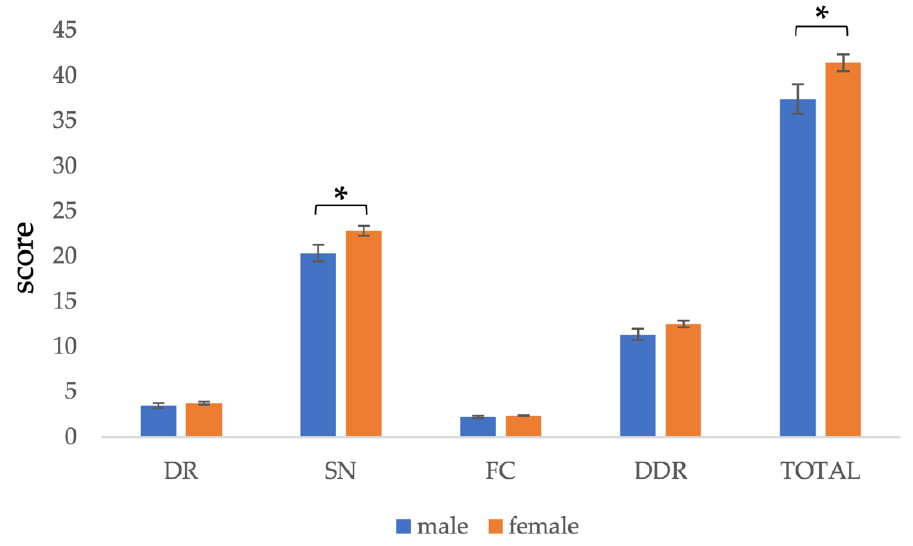
Figure 1. Comparison of C-GNKQ scores between males and females. Error bars represent standard errors. * indicates p < 0.05 . DR: dietary recommendations, SN: sources of nutrients, FC: daily food choice, and DDR: diet–diseases relationship.